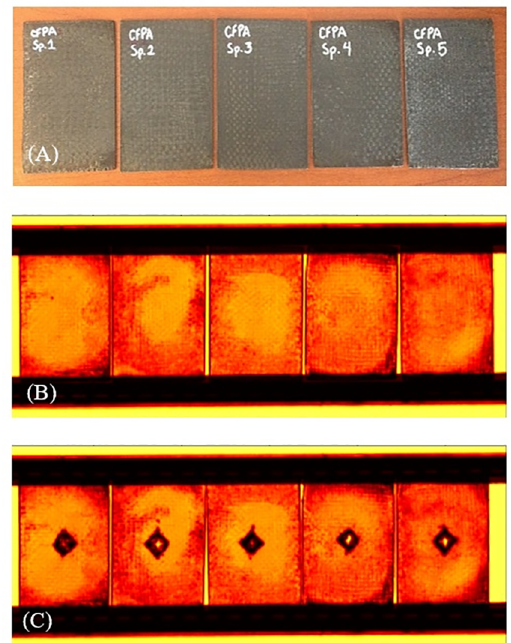
Figure 7. C-scan ultrasound inspection. (A) CF/PA commingled composite samples. (B) Before impact event. (C) After impact event. (Bibliographic Source: Author.)